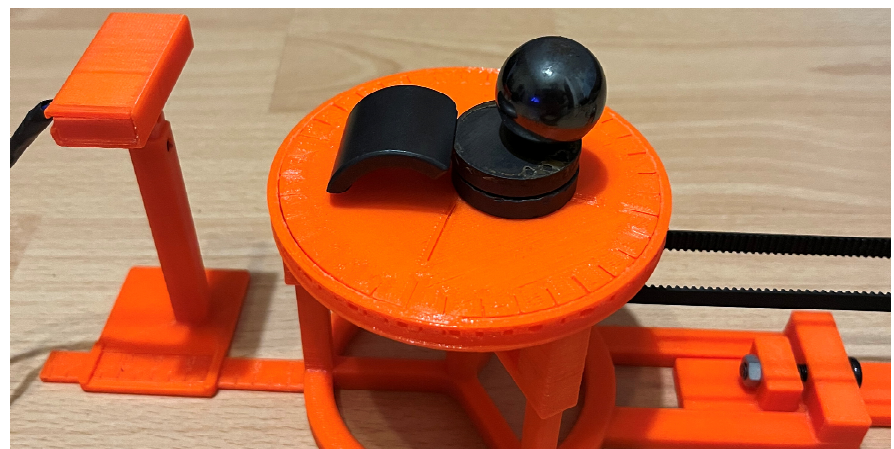
Figure 21. A system of several permanent magnets used during measurements of an irregular magnetic field.